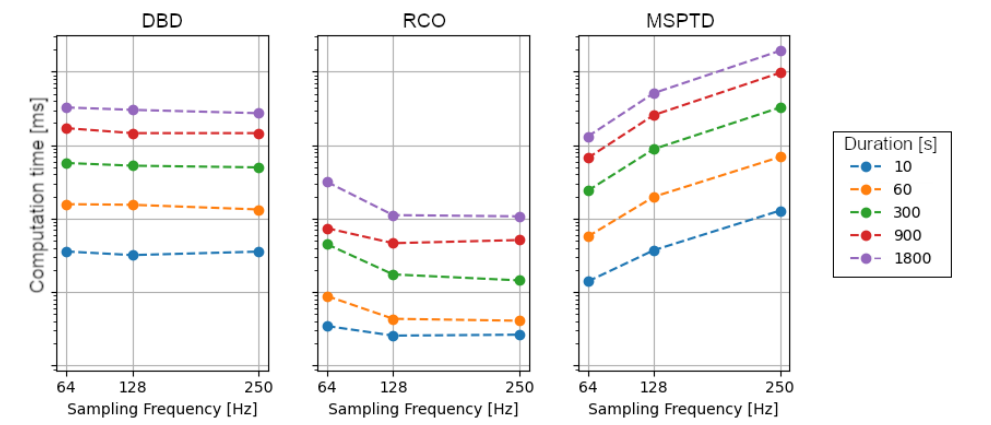
Figure 7. Computation times of the heartbeat detection algorithms for increasing sampling frequency and duration of the signals.